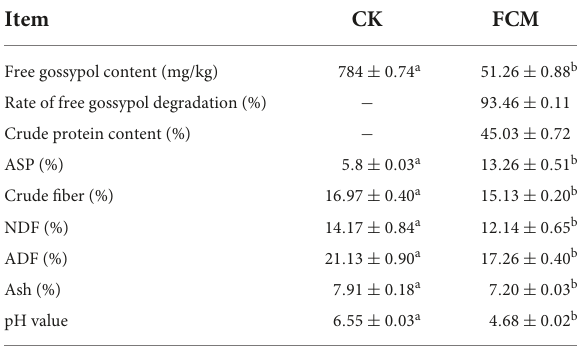
TABLE 2 Relevant indexes of fermented cottonseed